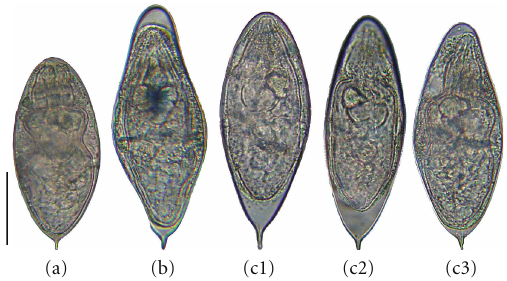
Figure 2: Egg morphology. Typical morphologies of eggs of the S. haematobium morphotype (a), the S. guineensis morphotype (b), and the morphotype intermediate between S. haematobium and S. guineensis (c). Bar represents 50 µ